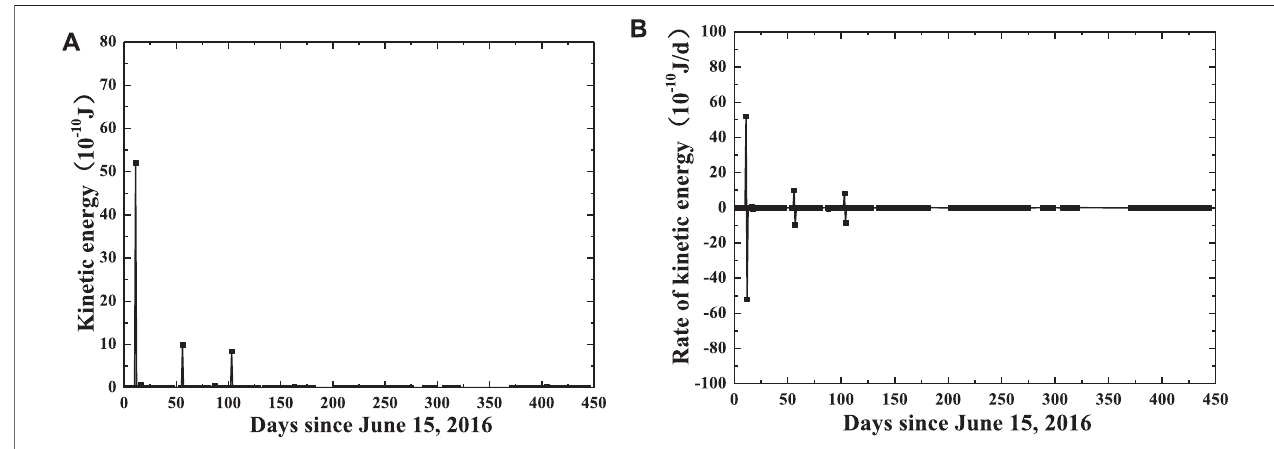
FIGURE 14 | (A) Kinetic energy and (B) its rate based on the deep displacement calculated by Eqs 3 , 4 , respectively.